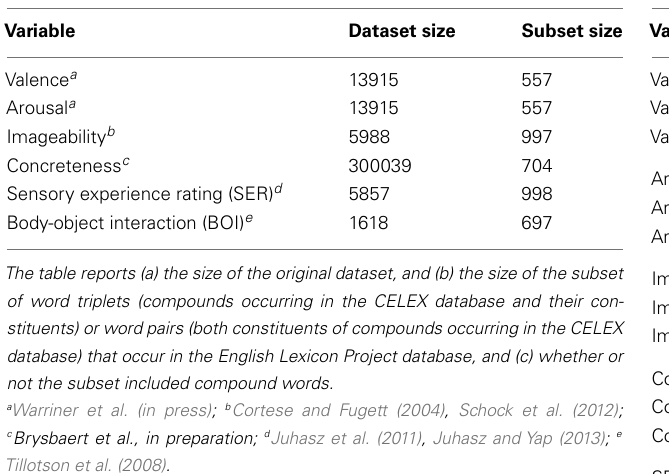
Table 1 | Summary of datasets of semantic variables used in this study. Table 2 | Descriptive statistics of semantic variables used in the